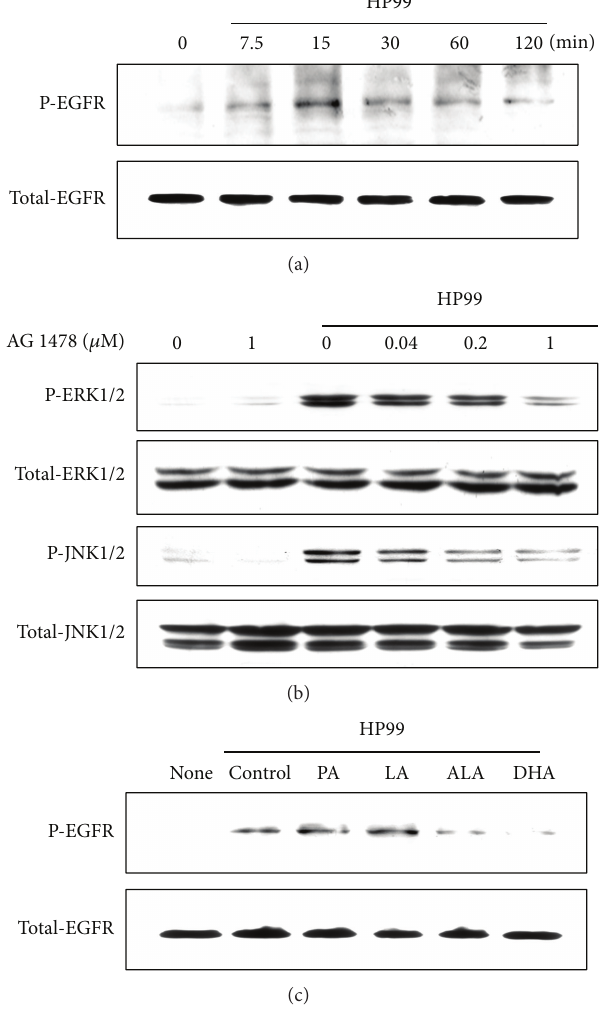
Figure 5: Effects of PUFAs on EGFR activation in H. pylori - infected AGS cells. (a) AGS cells were infected with H. pylori for the indicated time points (7.5, 15, 30, 60, and 120min). Phosphospecific and total forms of EGFR were determined by western blotting. (b) AGS cells were pretreated with various concentrations of tyrphostin AG1478 (0.04, 0.2, and 1 𝜇 M), a specific EGFR inhibitor, for 1h prior to H. pylori stimulation The cells were then infected with H. pylori for 30 min and phospho-ERK and phospho-JNK levels were determined by western blotting. (c) AGS cells were pretreated with individual fatty acid (100 𝜇 M) for 24 h and were then infected with H. pylori for 15